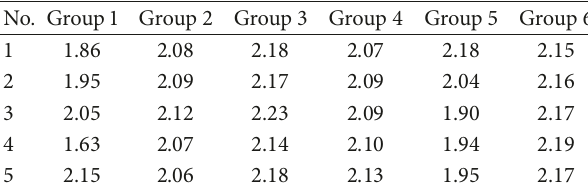
Table 4: OD value of RNA.